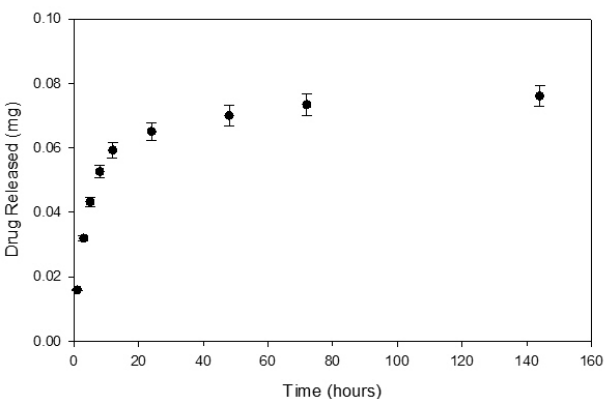
Figure 9. Dexamethasone release curve from loaded poly(HEMA, BAC, 3AAPBA) nanoparticles prepared according to sample C3 in Table 2 released from 50 kDa MWCO dialysis tubing under sink conditions. Initial loading of dexamethasone was 5.3% (±0.4%). Error bars were determined from the